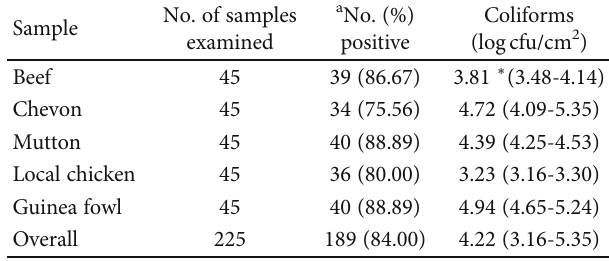
Table 1: Prevalence of Escherichia coli and coliform counts in meat samples sold at the Tamale